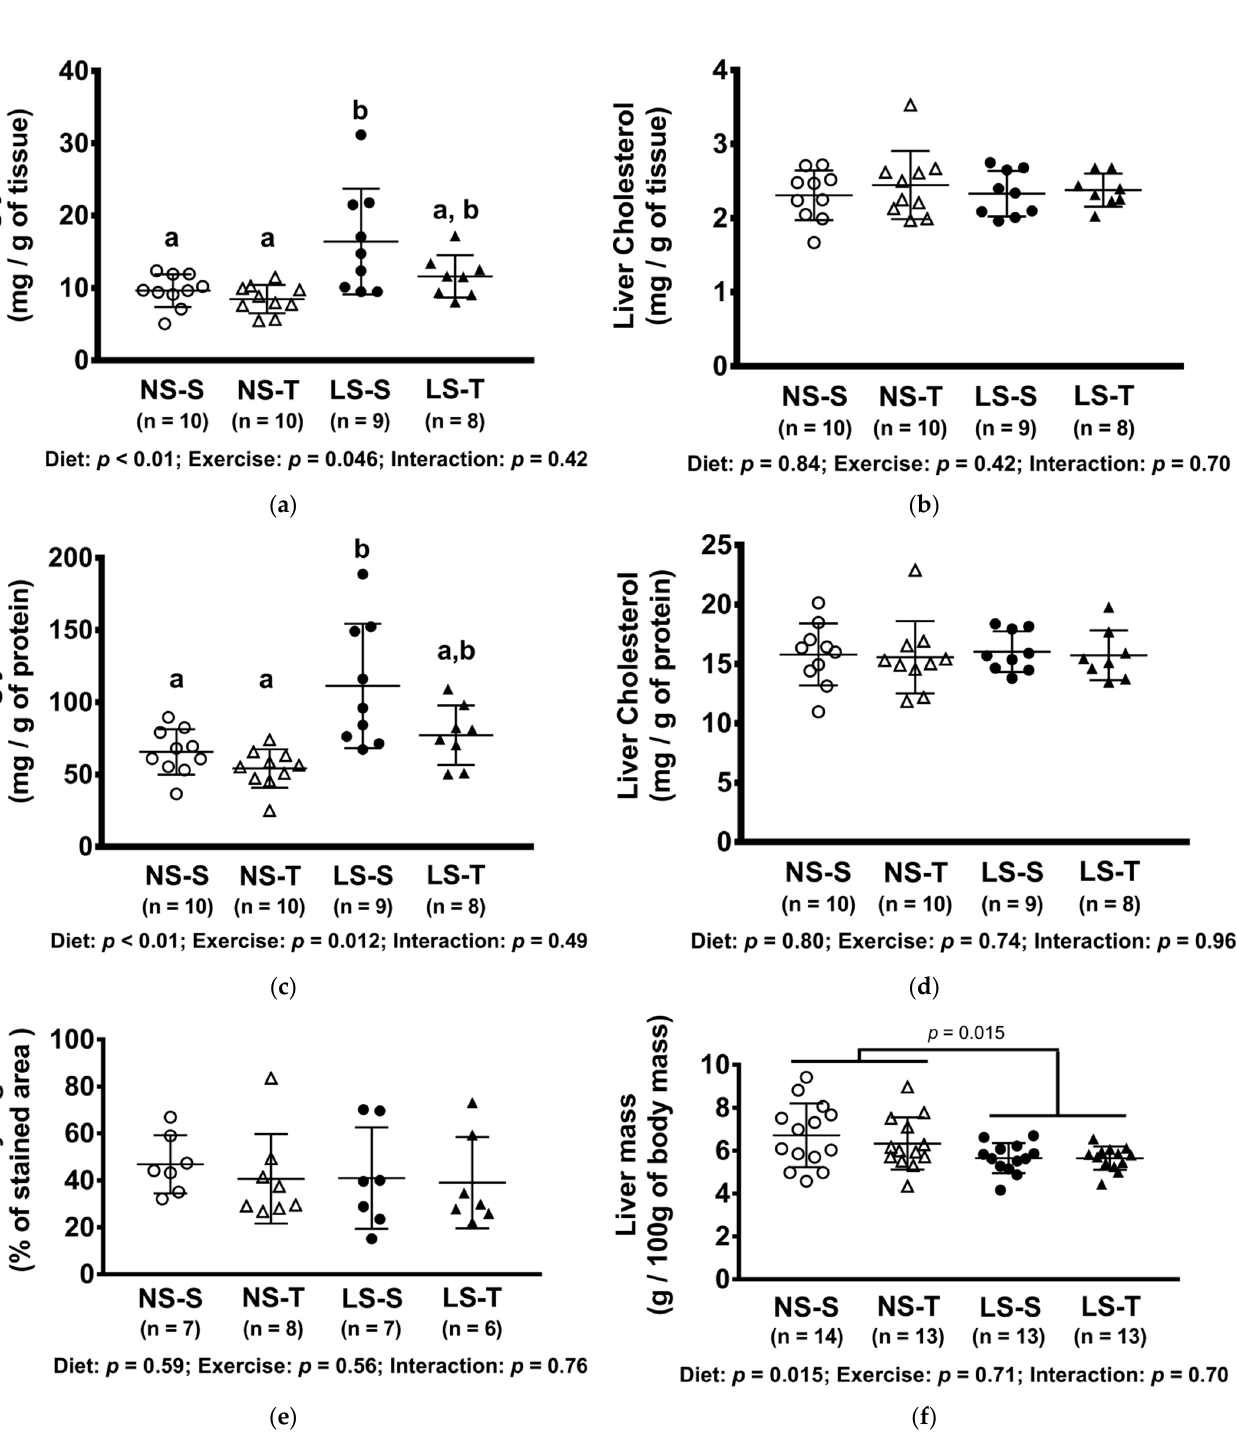
Figure 5. Concentration of hepatic lipids and glycogen, and liver mass. ( a ) Triglycerides (mg/g of tissue); ( b ) cholesterol (mg/of tissue); ( c ) triglycerides (mg/g of protein); ( d ) cholesterol (mg/g of protein); ( e ) glycogen (% of stained area); ( f ) liver mass (g/100 g of body mass). Data presented as mean ± SD. Results compared by 2-way ANOVA (GLM; fixed factor: diet and exercise) with Tukey’s post hoc test. Distinct letters represent statistical differences between groups ( p < 0.05). NS = normal-sodium diet; LS = low-sodium diet; S = sedentary; T = trained.